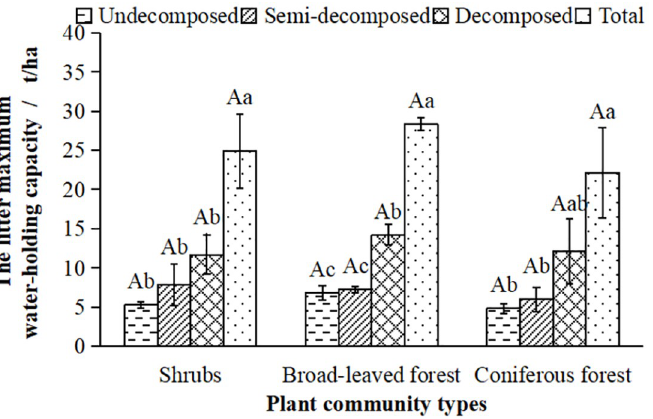
Fig 4. The maximum water-holding capacity( M